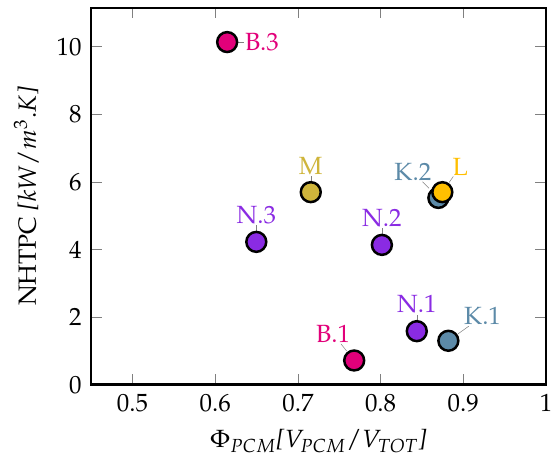
Figure 4. Calculated NHTPC vs. Φ PCM for the references concerning carbon based structures and metal foams as TCE in LHES unit